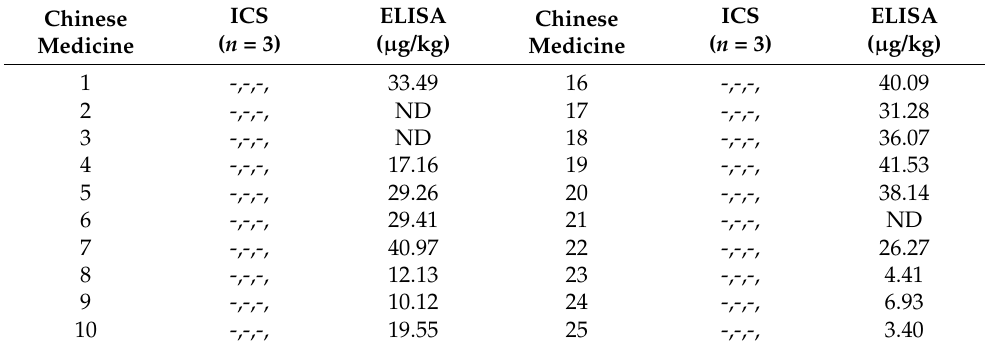
Table 2. ICS and ELISA detection results of T-2 in traditional Chinese medicine